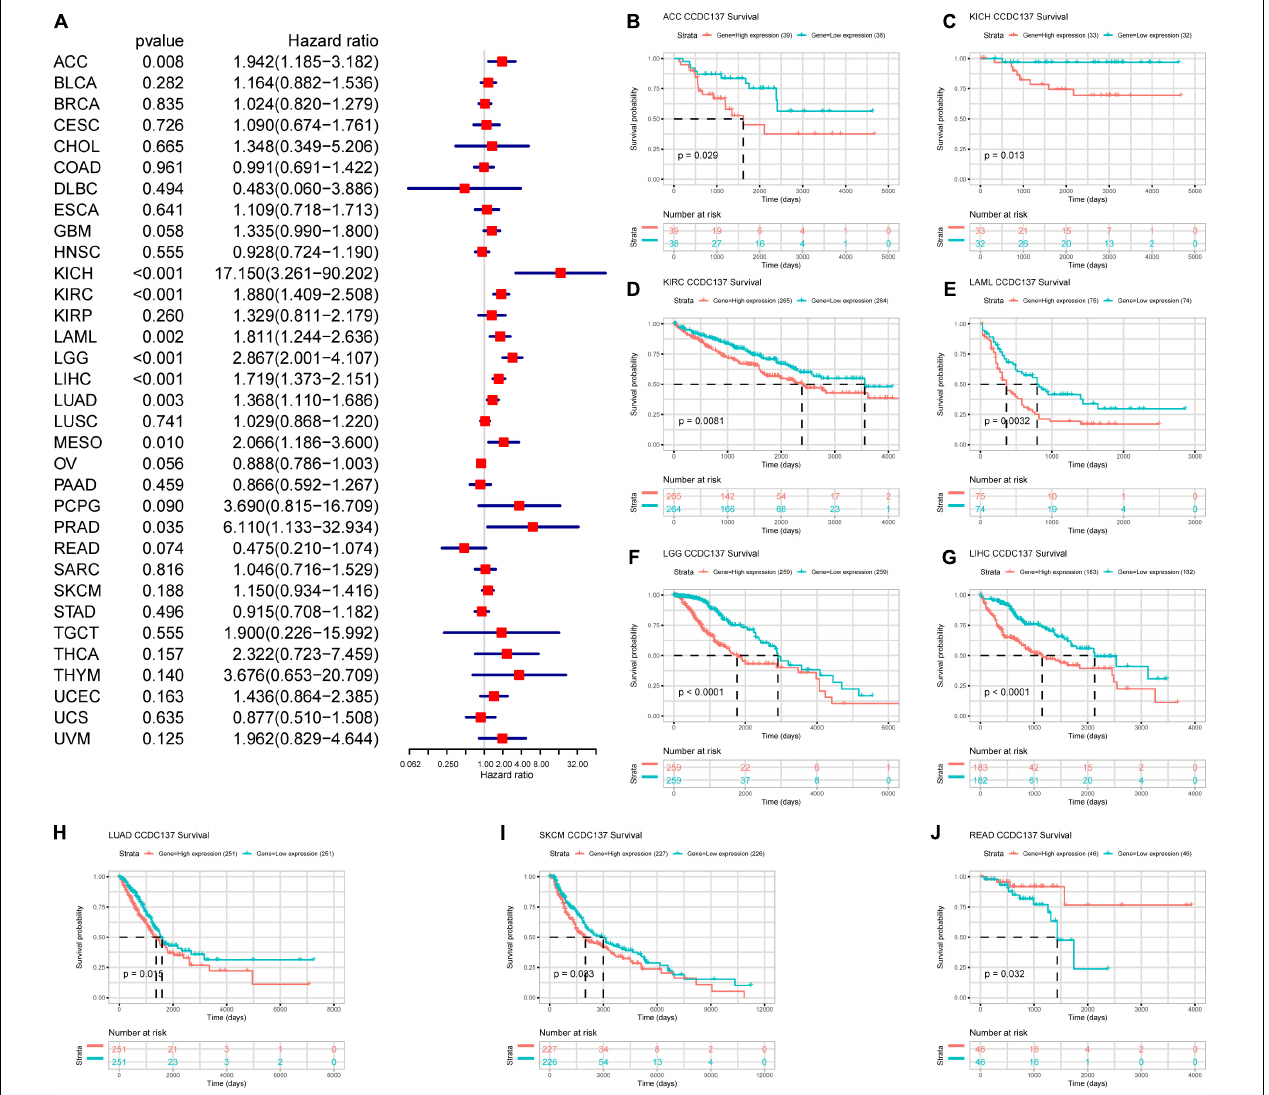
FIGURE 5 | Prognosis value of CCDC137 in TCGA pan-cancer. (A) The forest map shows the results of Univariate Cox Regression analysis for OS. (B–J) Kaplan–Meier survival analysis of CCDC137 in indicated tumor types. Only tumor types with log rank p < 0.05 were